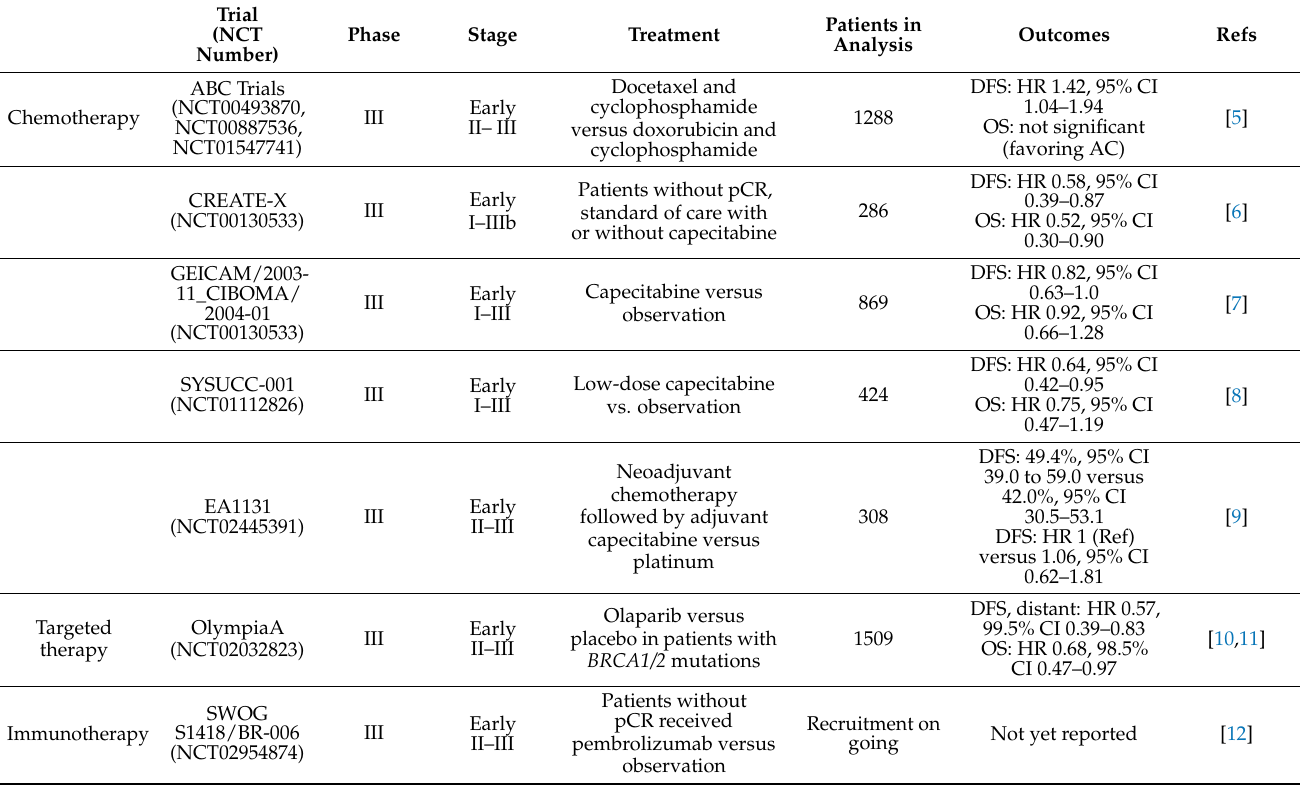
Table 1. Adjuvant Triple Negative Breast Cancer (TNBC) curative-intent treatment.